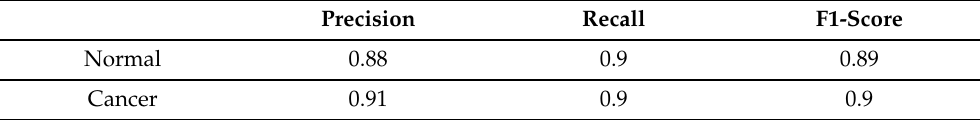
Table 2. Normal and cancer prediction accuracy using various classification matrices. Precision Recall F1-Score Normal